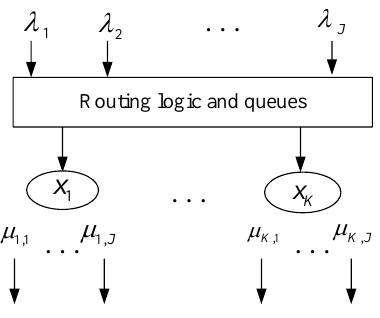
Figure 3. A one-period multi-skill call center consisting of J call types and K agent groups.